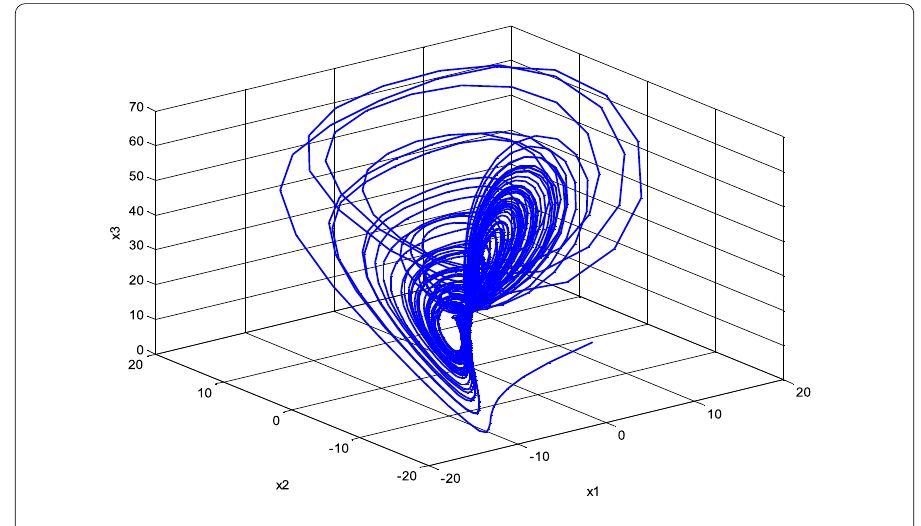
Figure 2 Chaotic behavior of the Lu fractional-order system